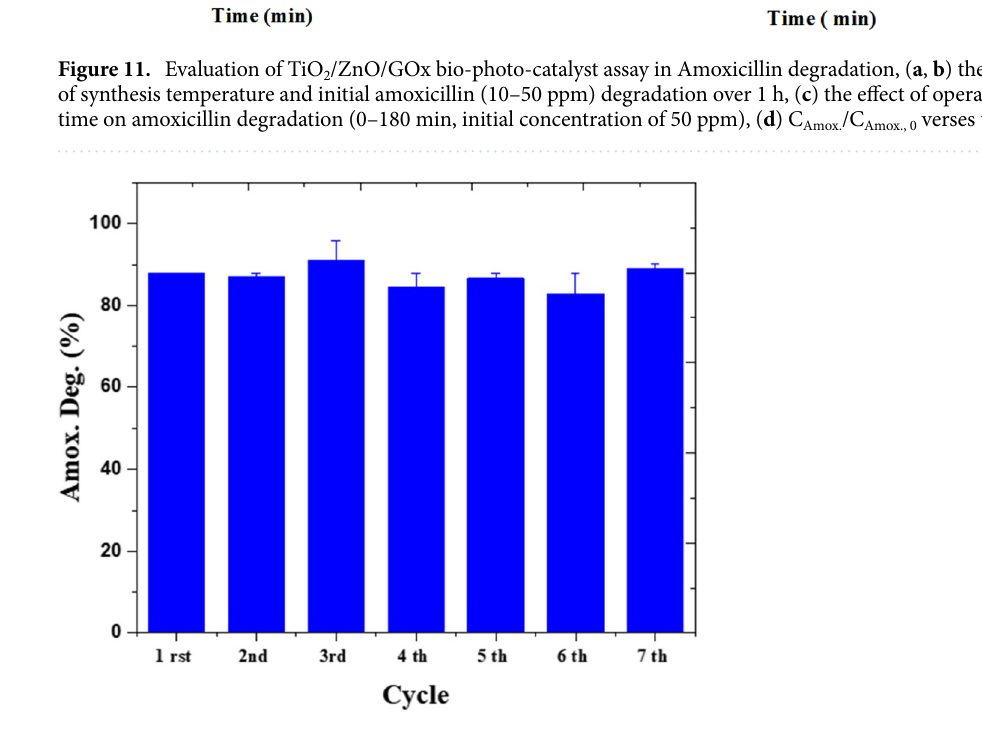
Figure 12. Repeated use of the biophotocatalyst for amoxicillin